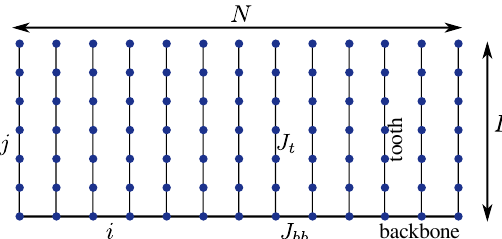
Figure 1: (Color online) Sketch of the comb lattice. Each tooth corresponds to a finite-size spin-1 / 2 Heisenberg chain with nearest-neighbor coupling constant J Edge spins on one edge of the tooth are coupled along the backbone with coupling constant J bb